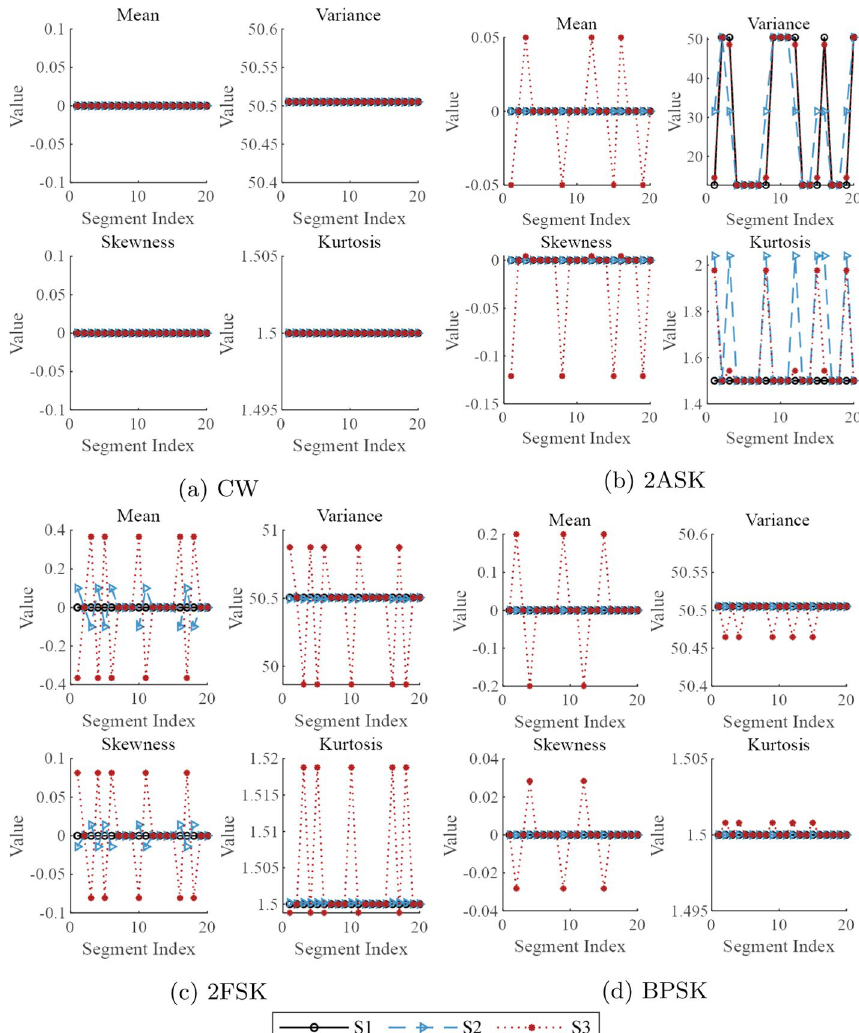
Fig. 8 Moments using different segmenting